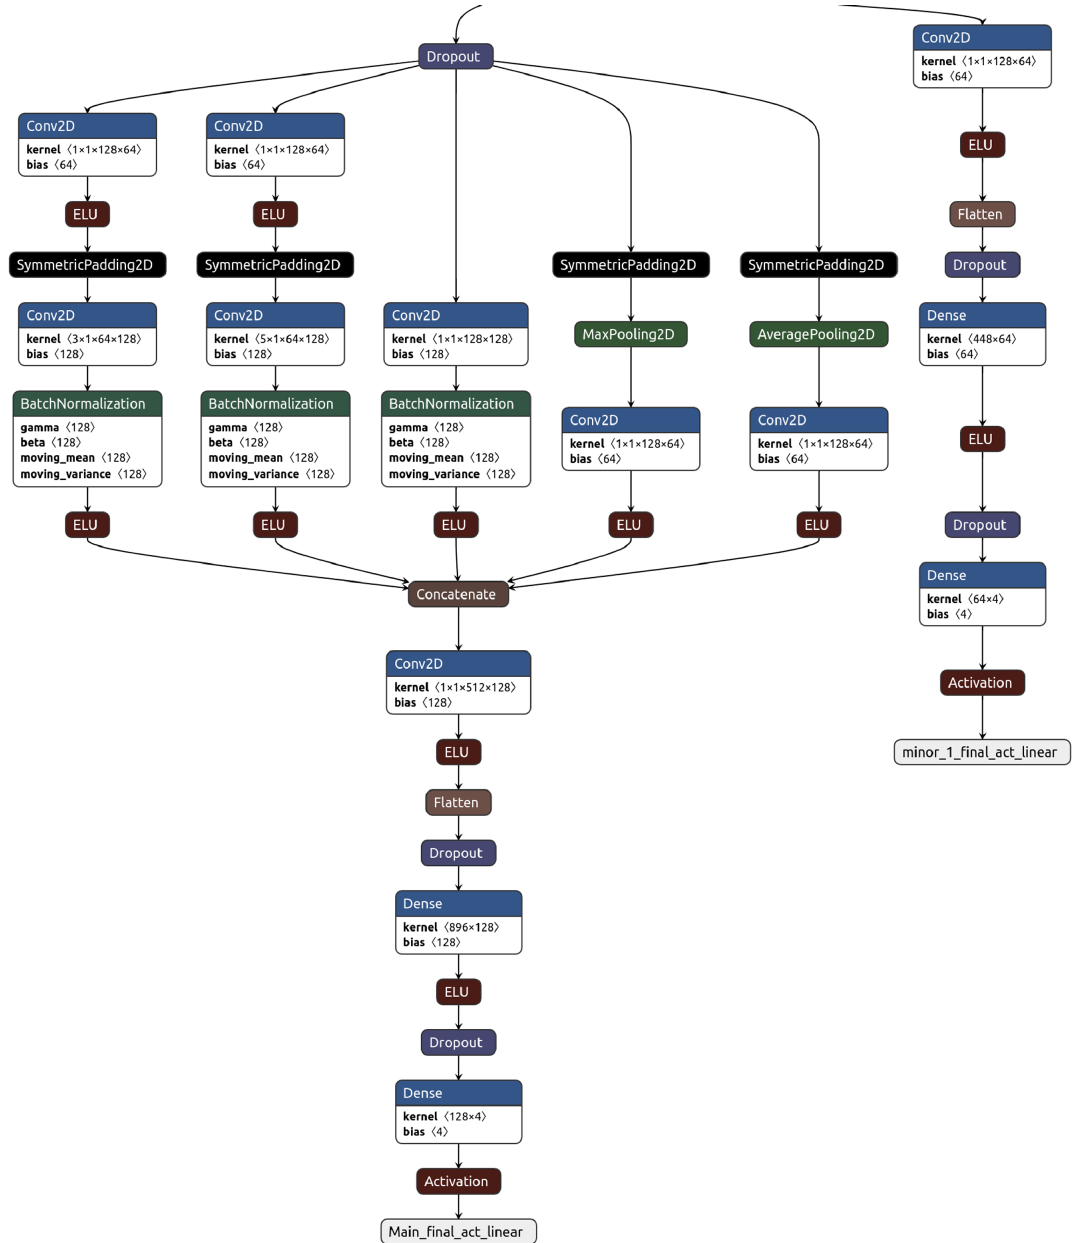
Figure A3. Second part of the network after the “concatenate” layer in Fig. A2, showing the minor output branch, the second inception block, and the main output branch. This figure was created with Netron (Roeder,